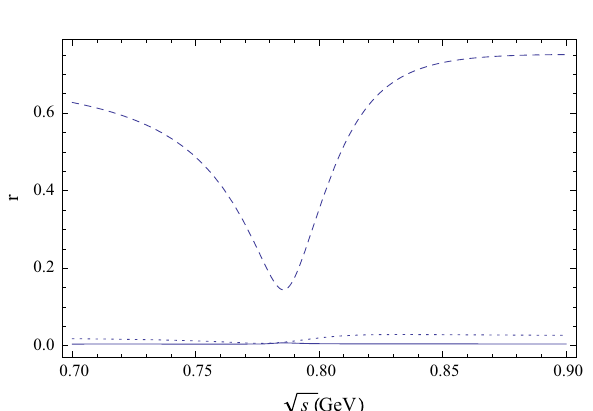
Fig. 2 sin δ as a function of corresponding to central parameter values of the CKM matrix elements for ¯ B 0 s → ρ 0 (ω)ρ 0 (ω) → π + π − π + π − . The dash line , dot line and solid line corresponds to sin δ 0 , sin δ + and sin δ − , respectively